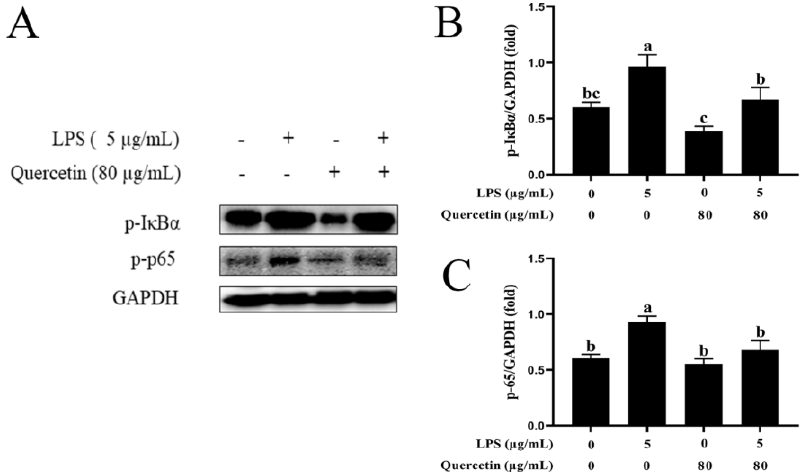
Figure 7. Impacts of quercetin on the NF- κ B signalling system. BIECs were treated with 80 µ g/mL quercetin in an environment of 5 µ g/mL LPS for 6 h. ( A ) Western blot evaluation of p-I κ B α and p-p65. ( B ) Relative protein expression levels of p-I κ B α to GAPDH. ( C ) Relative protein expression levels of p-p65 to GAPDH. The results are mean ± SEM (n = 3). Various lowercase letters in line graphs reveal significant changes ( p < 0.05).